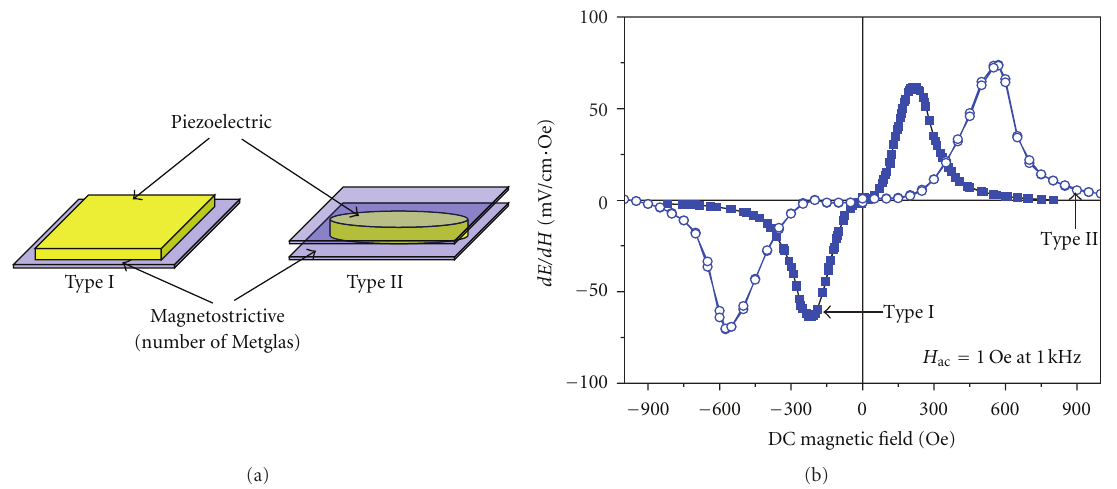
Figure 2: (a) Schematic diagram of fabricated samples: type I—15.5 × 15.5mm 2 PZNT plate with Metglas attached on one side only, and Type II—10.2 mm diameter PZNT disk with Metglas attached on both sides. (b) Magnetoelectric output voltage as a function of DC magnetic field [11].